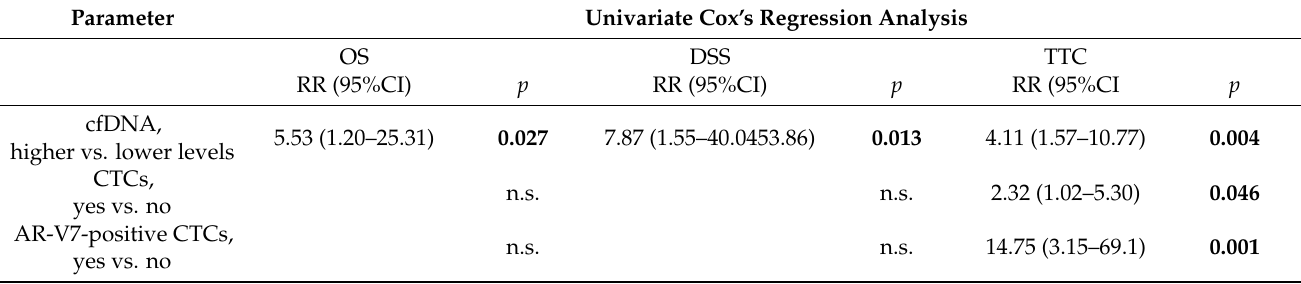
cfDNA, higher vs. lower levels CTCs, yes vs. no AR-V7-positive CTCs, yes vs. Table 5. Univariate Cox’s regression analysis: association of cfDNA levels, CTCs, or AR-V7-positive CTCs with prognosis. Parameter